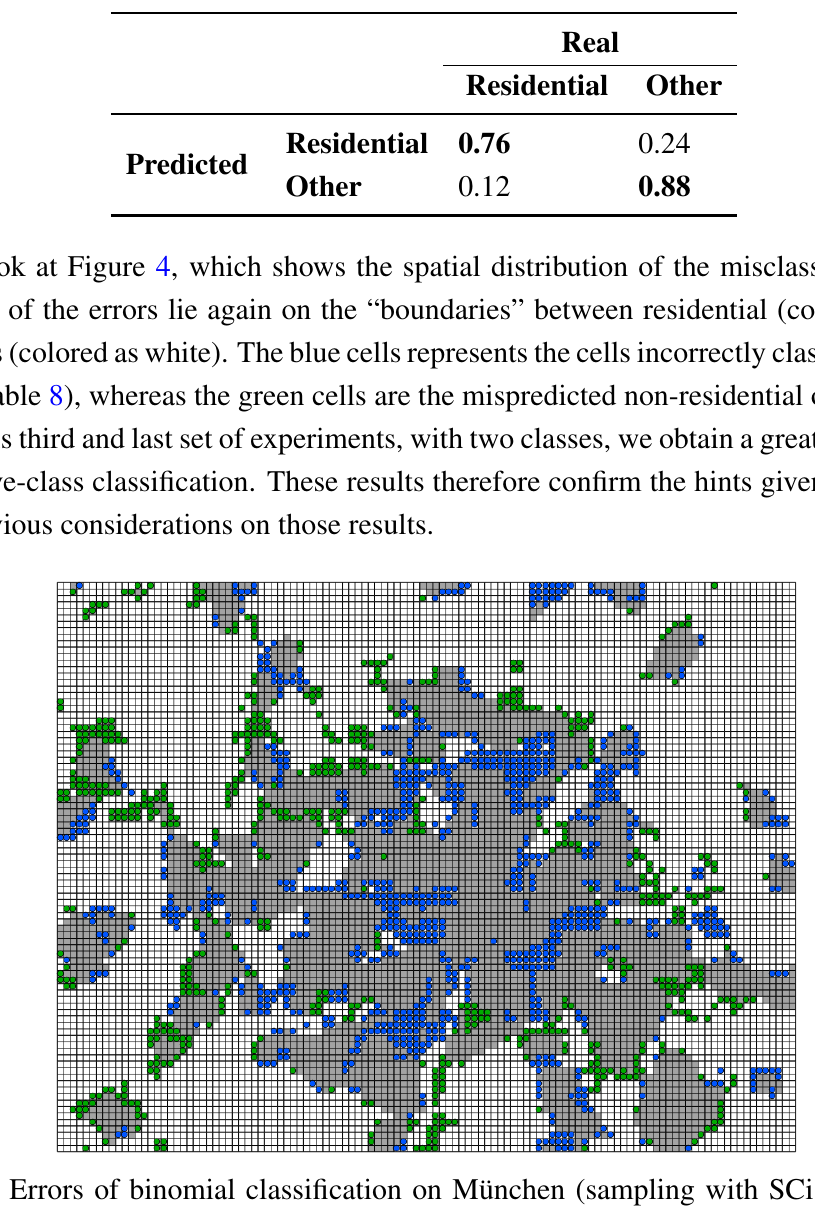
Table 8. Confusion matrix of München obtained with a binomial model sampled with SCi.SCl and 5 predictors.